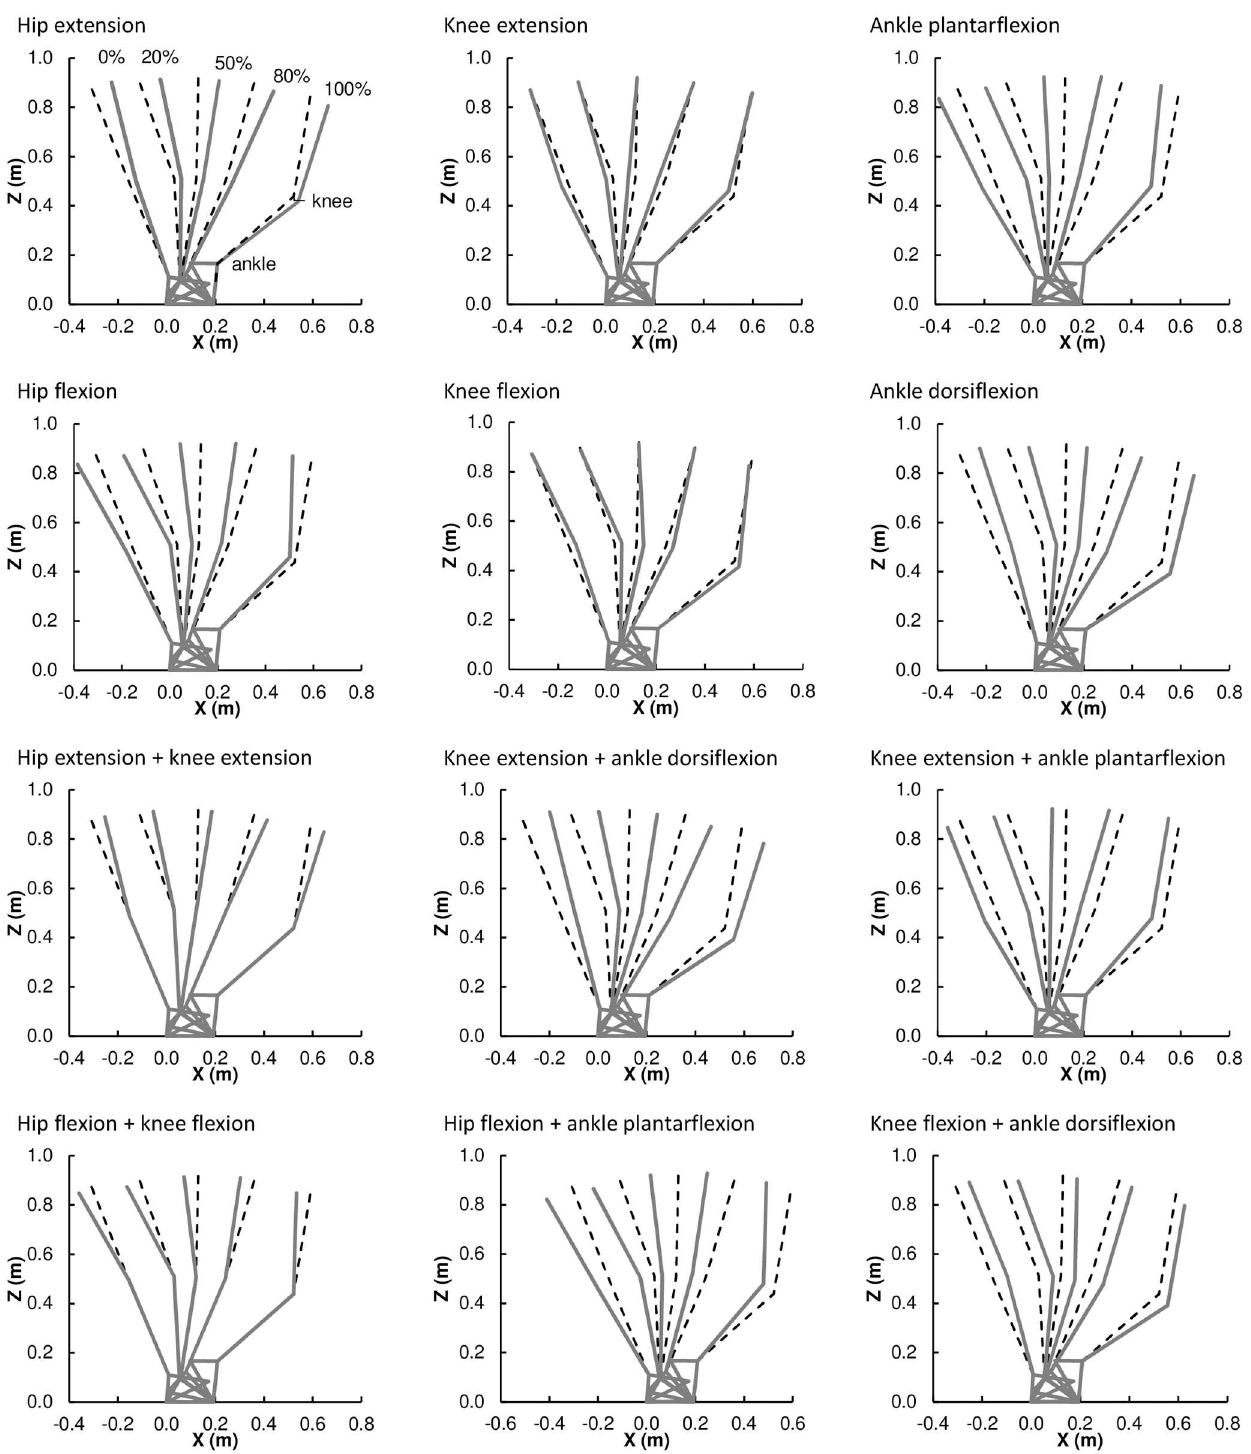
Fig 5. Diagram of lower limb postures after joint angle manipulation (gray) in comparison to the original posture (dashed black). The particularjoint angle changesfor each manipulation are specifiedin Table 3. Postures at 0%, 20%, 50%, 80%, and 100%of stance are depicted from left to